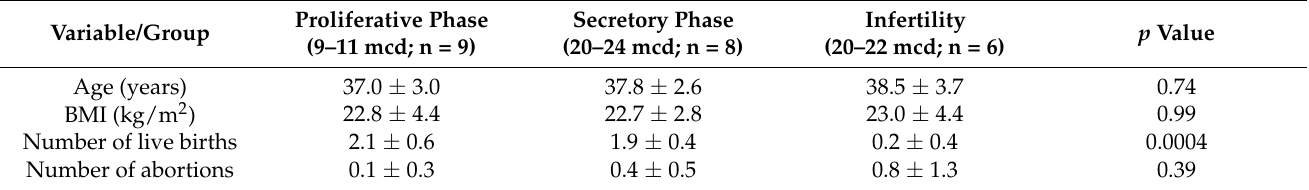
Table 1. Characteristics of endometrium